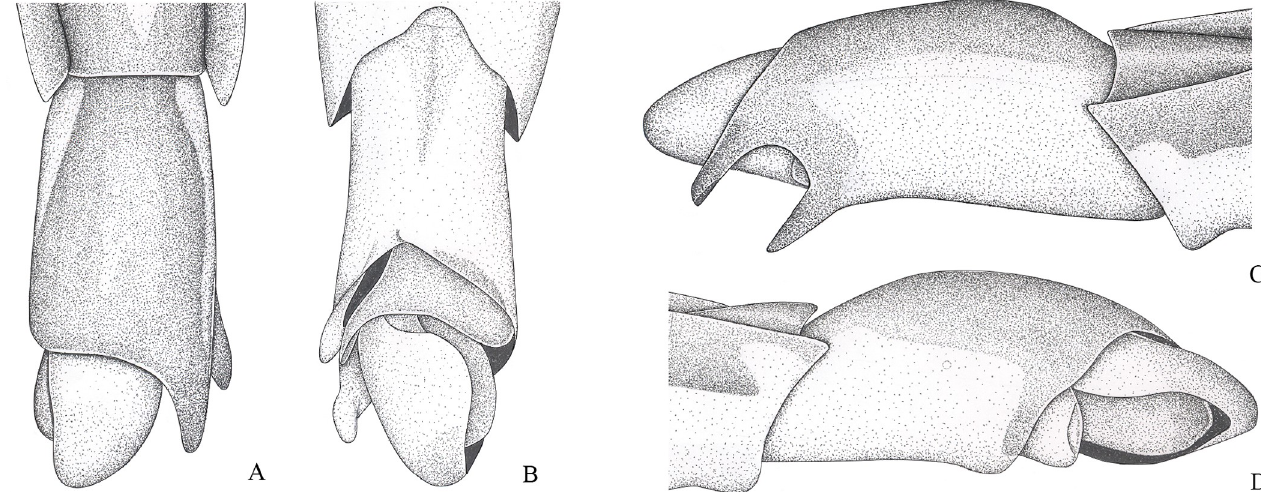
Fig 28. Potamobates williamsi . (A) Male, terminalia, dorsal view; (B) male, terminalia, ventral view; (C) male, terminalia, right lateral view; (D) male, terminalia, left lateral view.